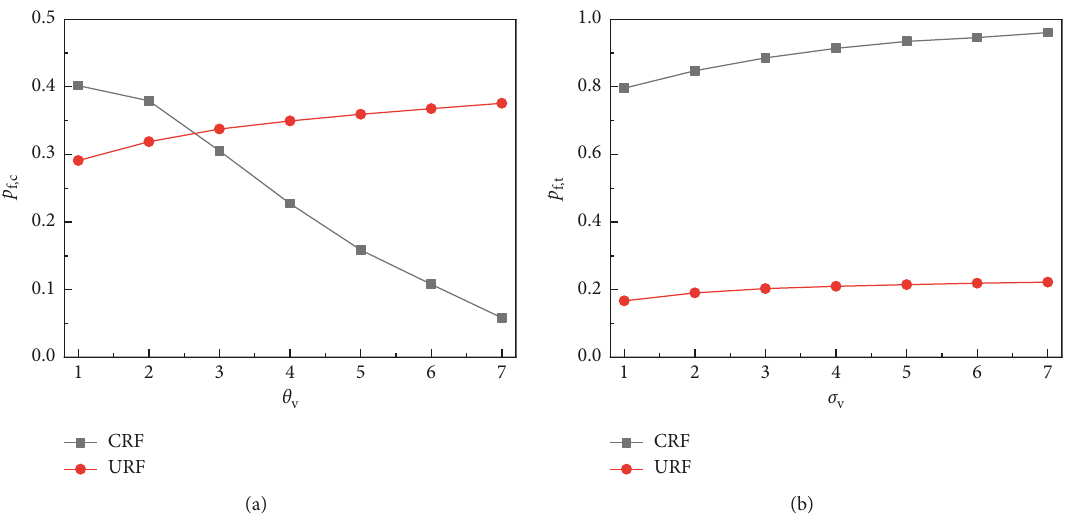
Figure 8: Effect of the vertical correlation length on the probability of failure of tunnel liner under both unconditional and conditional random fields: (a) compression failure and (b) tension failure.